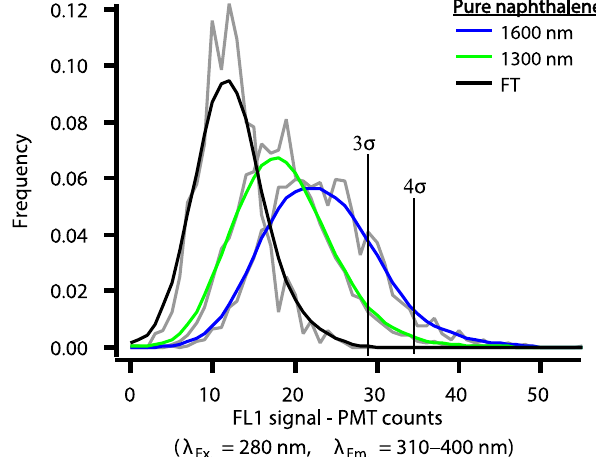
Figure 8. Fluorescence intensity histograms from the FL1 detector of size-selected naphthalene particles and forced trigger (FT) back- ground for a gain setting of 0.632V. Gray lines are the raw data, while colored lines are smoothed for visualization purposes for each size and for FT. Only the tails of the naphthalene distributions are above the fluorescence thresholds (3 σ and 4 σ thresholds for this gain setting are indicated by vertical black